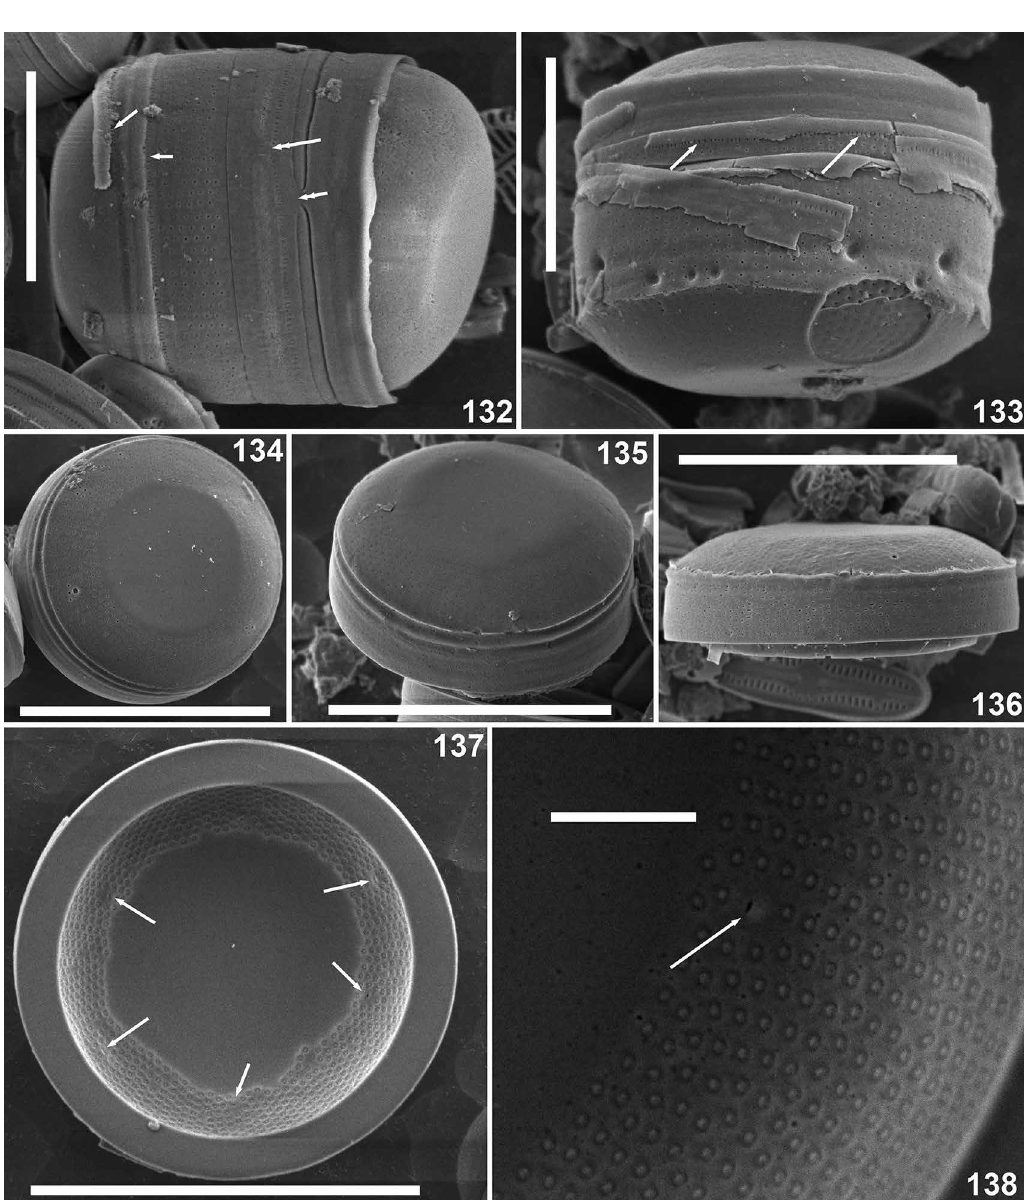
Figs 132–138. Arcanodiscus saundersianus Goeyers & Van de Vijver sp. nov. SEM. Campbell Island holotype population, sample BAS272 (BR-4581). 132 . Frustule in girdle view with the narrow copulae. The arrows indicate the ligulae. 133 . Frustule in girdle view with the narrow copulae. The arrows indicate the fimbriate pars interior of the copulae. Note also the domed valve face. Parts of the upper layer are eroded showing small areolae. 134–135 . External valve face views showing the relatively small central area and the well-developed marginal ridges. 136 . External view of a valve in girdle view showing the low, almost flat valve face, the absence of marginal ridges and the broad mantle edge. 137 . Internal views of an entire valve showing several rimoportulae (arrows). 138 . Internal detail of the valve with an indicated rimoportula. Note also the rota on the areolae. Scale bars: 132–137 = 10 μm; 138 = 1